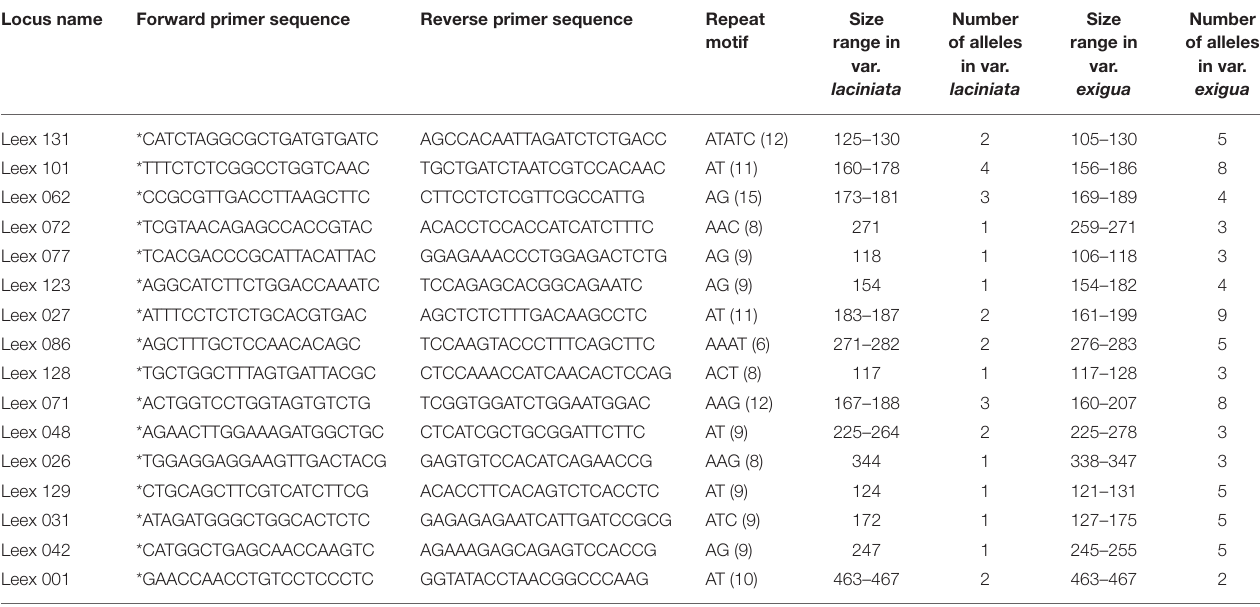
TABLE 2 | Leavenworthia exigua microsatellite primer